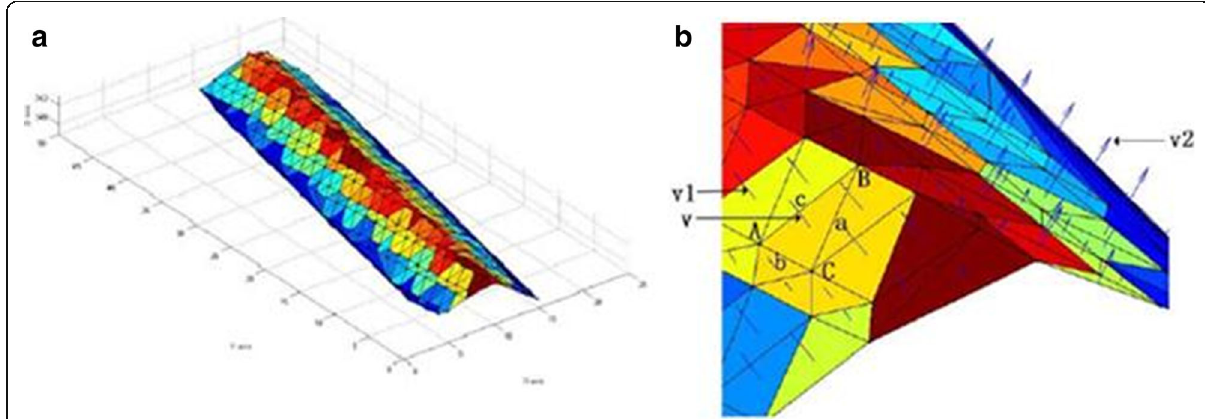
Fig. 2 TIN model and surface normal vector. a TIN model. b Surface normal vector